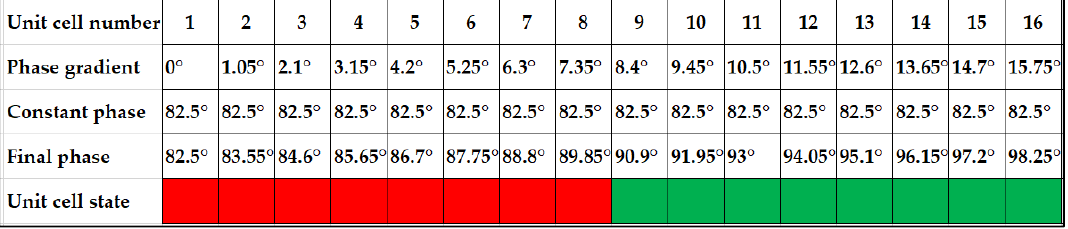
Figure 4. MS phase and state distribution using a constant phase.